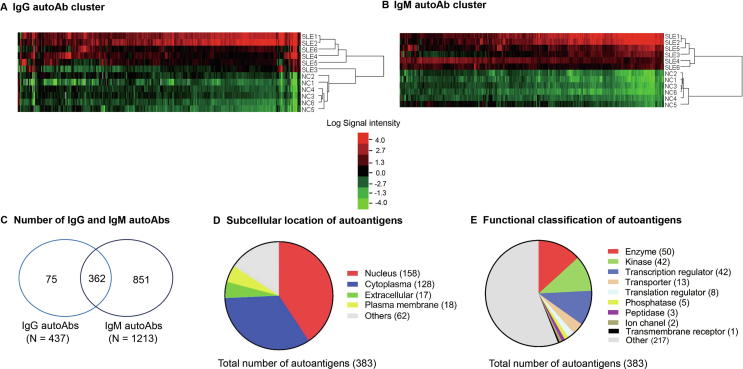
Clustering and classification of differentially expressed IgG and IgM autoAbs in SLE and NC by ProtoArrayA. Clustering and heatmap analyses of the 437 IgG autoAbs with significantly increased levels in SLE (P < 0.05; Mann-Whitney U test). Red indicates increased expression and green indicates decreased expression in SLE as compared with NC. B. Clustering and heatmap analyses of 1218 IgM autoAbs with significantly-elevated levels in SLE (P < 0.05). C. Venn diagram of IgG and IgM autoAbs. There are 362 autoAbs commonly detected in both IgG and IgM subtypes. D. Subcellular localization of the 383 unique antigens targeted by 437 IgG autoAbs. E. Functional classification of the 383 unique autoantigens targeted by IgG autoAbs using IPA. SLE, systemic lupus erythematosus; NC, healthy control; autoAb, autoantibody.